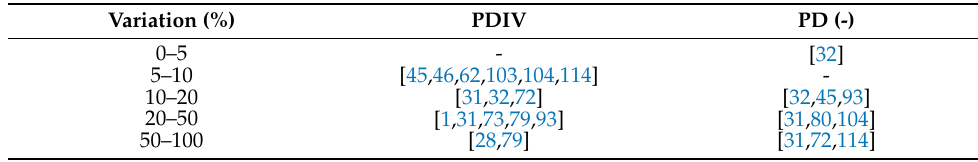
Table 17. Maximal variations of the partial discharge inception voltage and magnitude of the discharges in